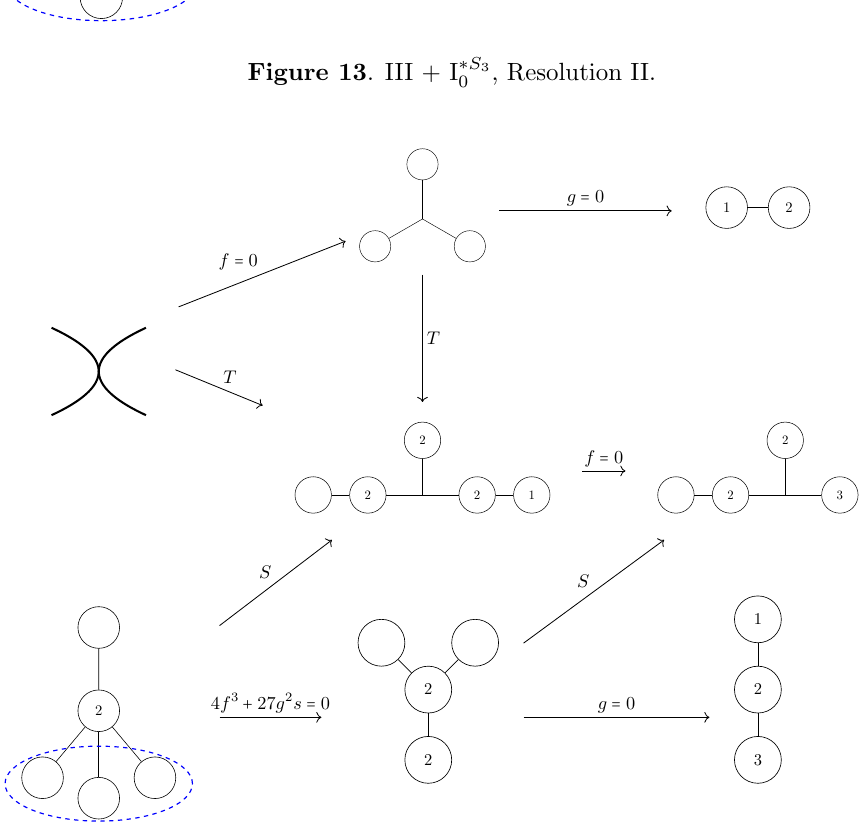
Figure 14 . III + I (cid:3) S 3